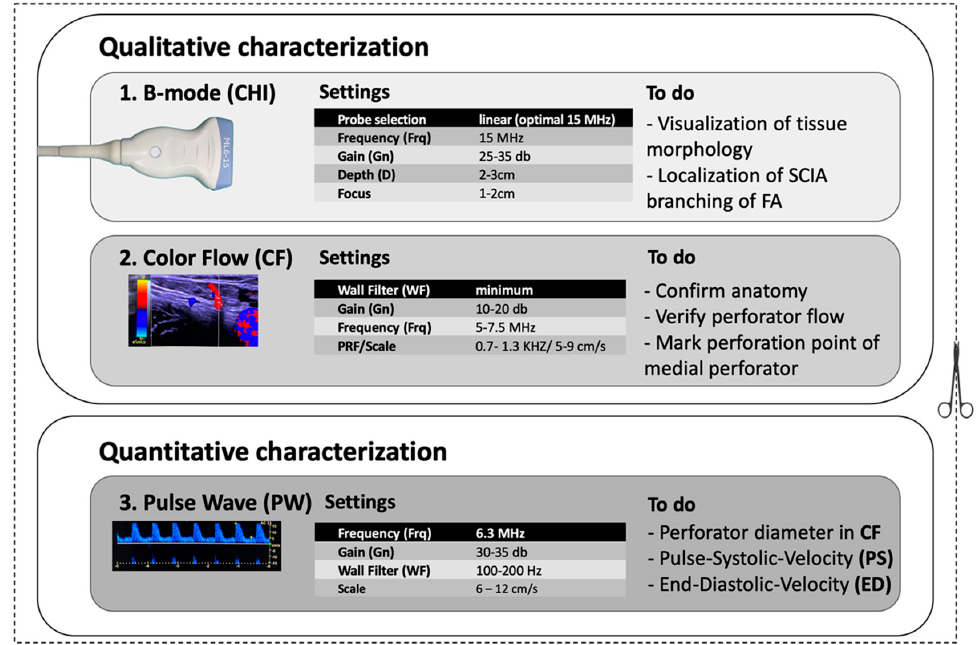
Figure 4. Structured procedure for ultrasound-guided flap design of the SCIP flap.